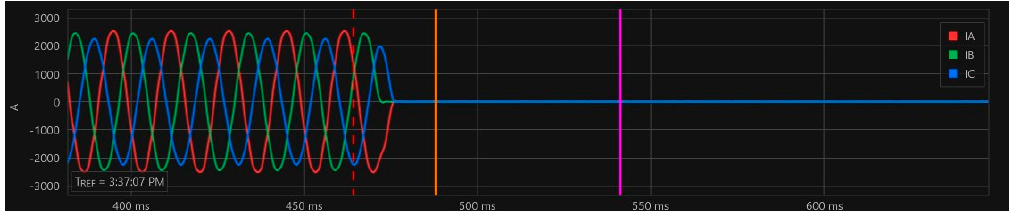
Figure 38. Event obtained for phase currents recorded by R1 under IDMT scheme.